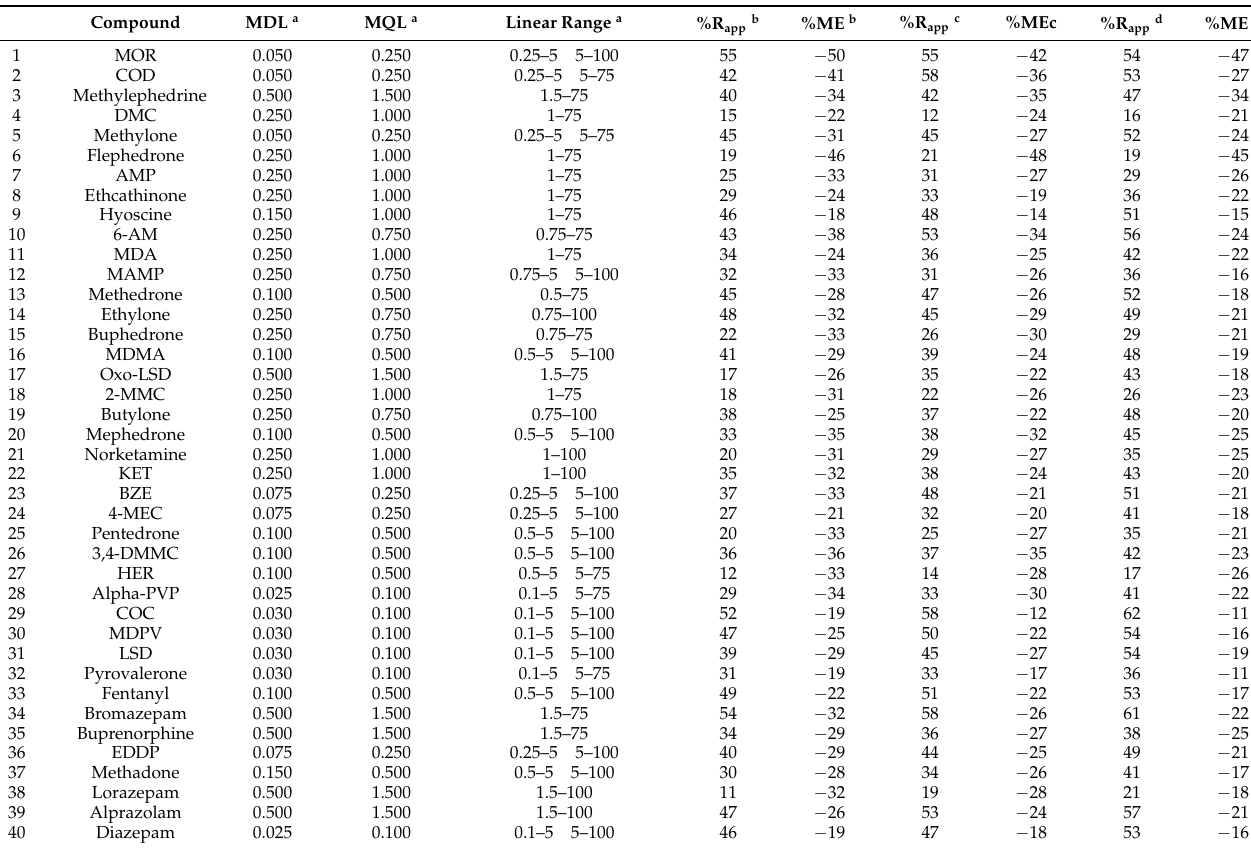
Table 2. Validation parameters of the DOAs under